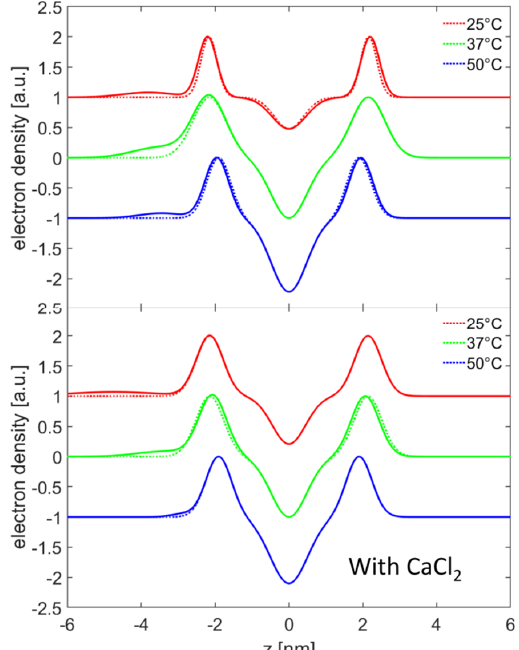
Figure 5. Electron density profiles obtained by the model fitting of the SAXS data on vesicles of DPPC with HA with an MW of 250 kDa (dashed lines) and without HA (solid lines). The curves were measured at different temperatures corresponding to the L β0 (25 °C), P β0 (37 °C) and L α (50 °C) phase. ( Top ): 150 mM sodium chloride solutions. ( Bottom ): 150 mM sodium chloride with 10 mM calcium chloride solutions.